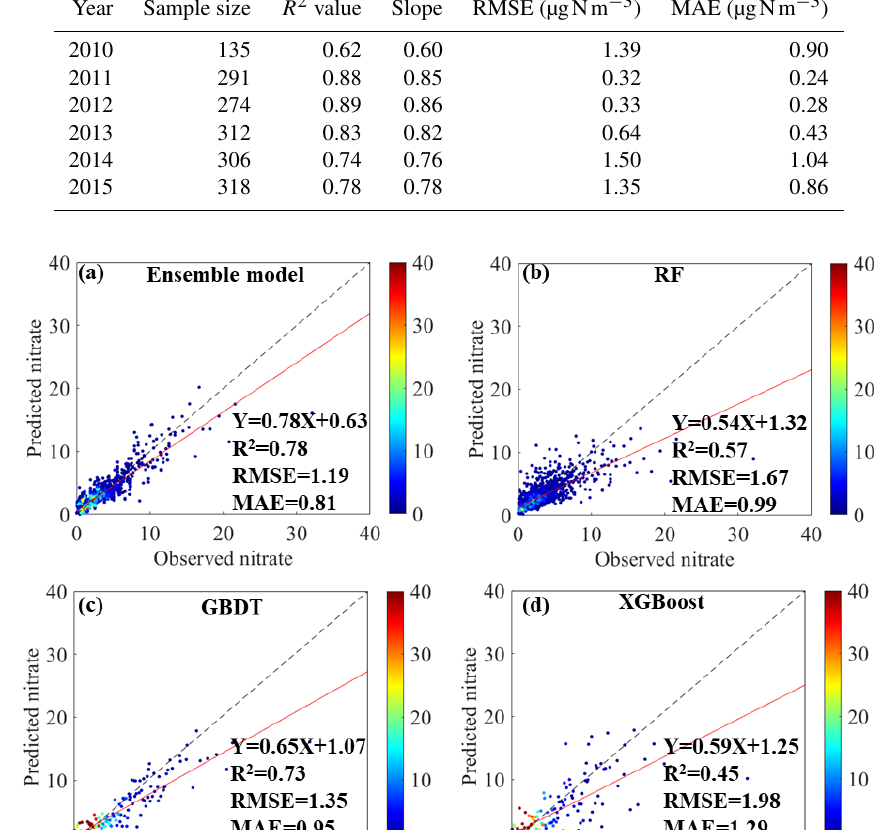
− estimation over China during 2010–2015. 3